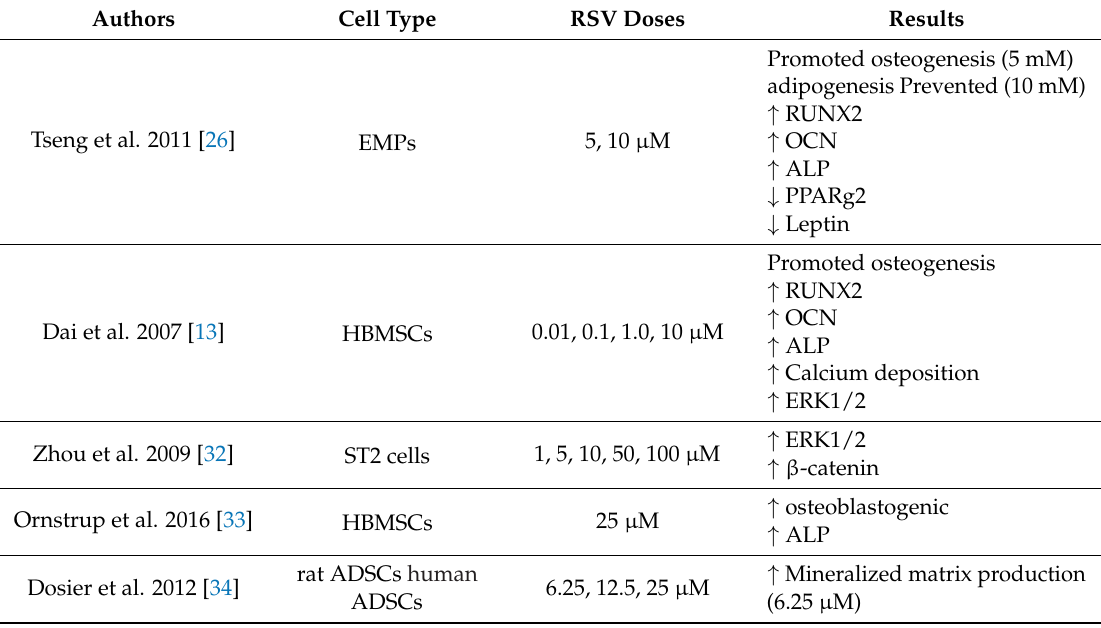
Table 1. Summary of Resveratrol’s in vitro